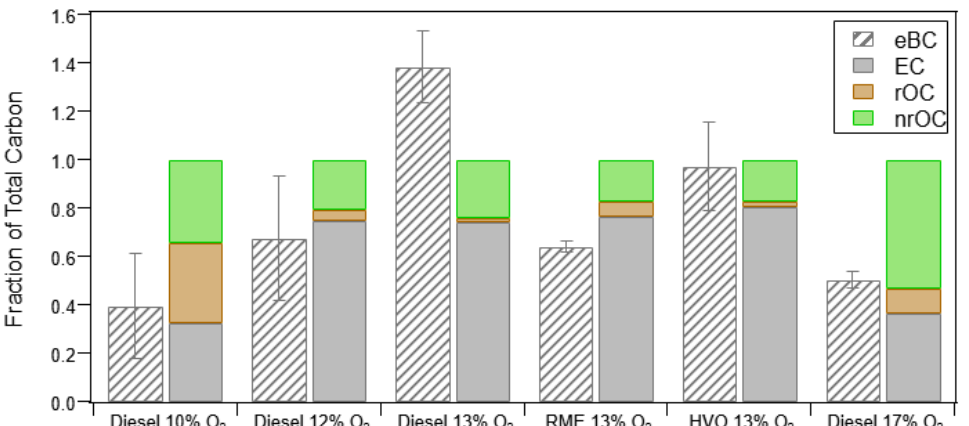
Figure 3. equivalent Black Carbon (eBC), elemental carbon (EC), refractory organic carbon (rOC), non-refractory organic carbon (nrOC) mass emissions normalized to the total carbon concentration (the sum of EC, rOC and nrOC) for the di ff erent intake O 2 concentrations and fuels. Black carbon (eBC) concentrations with ± 1 std. dev. were simultaneously measured online with the Photo-acoustic technique (MSS). The carbon content of the filter collected aerosol mass was measured with the thermal-optical analysis, and classified into three di ff erent categories, elemental carbon (EC) and organic carbon (OC) subdivided into two categories. The OC categories were non-refractory OC (nrOC) that evolves at temperatures up to 450 ◦ C, and refractory OC (rOC) that evolves at temperatures exceeding 450 ◦ C (in inert He) or detected in an oxidizing atmosphere (pyrolytic carbon). The nrOC corresponds to the sum of OC1, OC2 and OC3, rOC correspond to the sum of OC4 and pyrOC in the EUSAAR_2 protocol. The total carbon content is the sum of EC, rOC and nrOC. Non-refractory OC (especially in the OC1-OC2 channels) may have been overestimated due to positive artefacts from adsorption of gas phase OC on the quartz filters (no back-up filter was used). This would have a ff ected samples with low collected particle masses the most, in this case diesel 13% and diesel